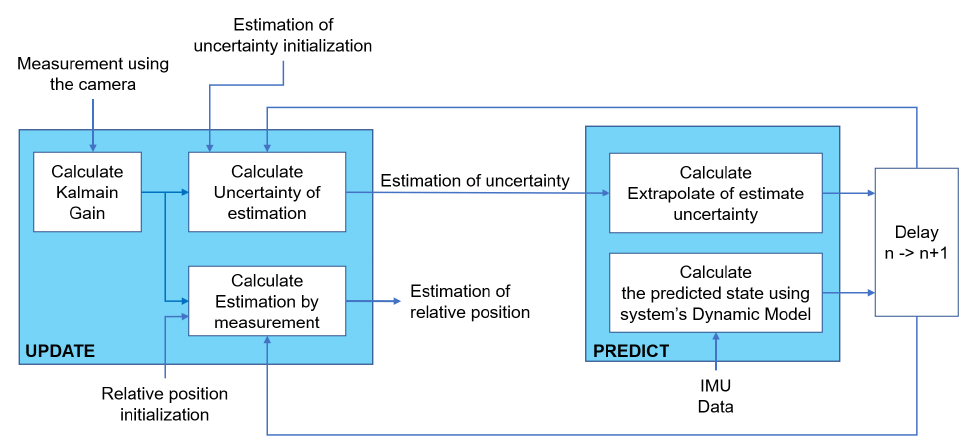
Figure 9. Architectural diagram of the process of fusing camera and IMU data using EKF.